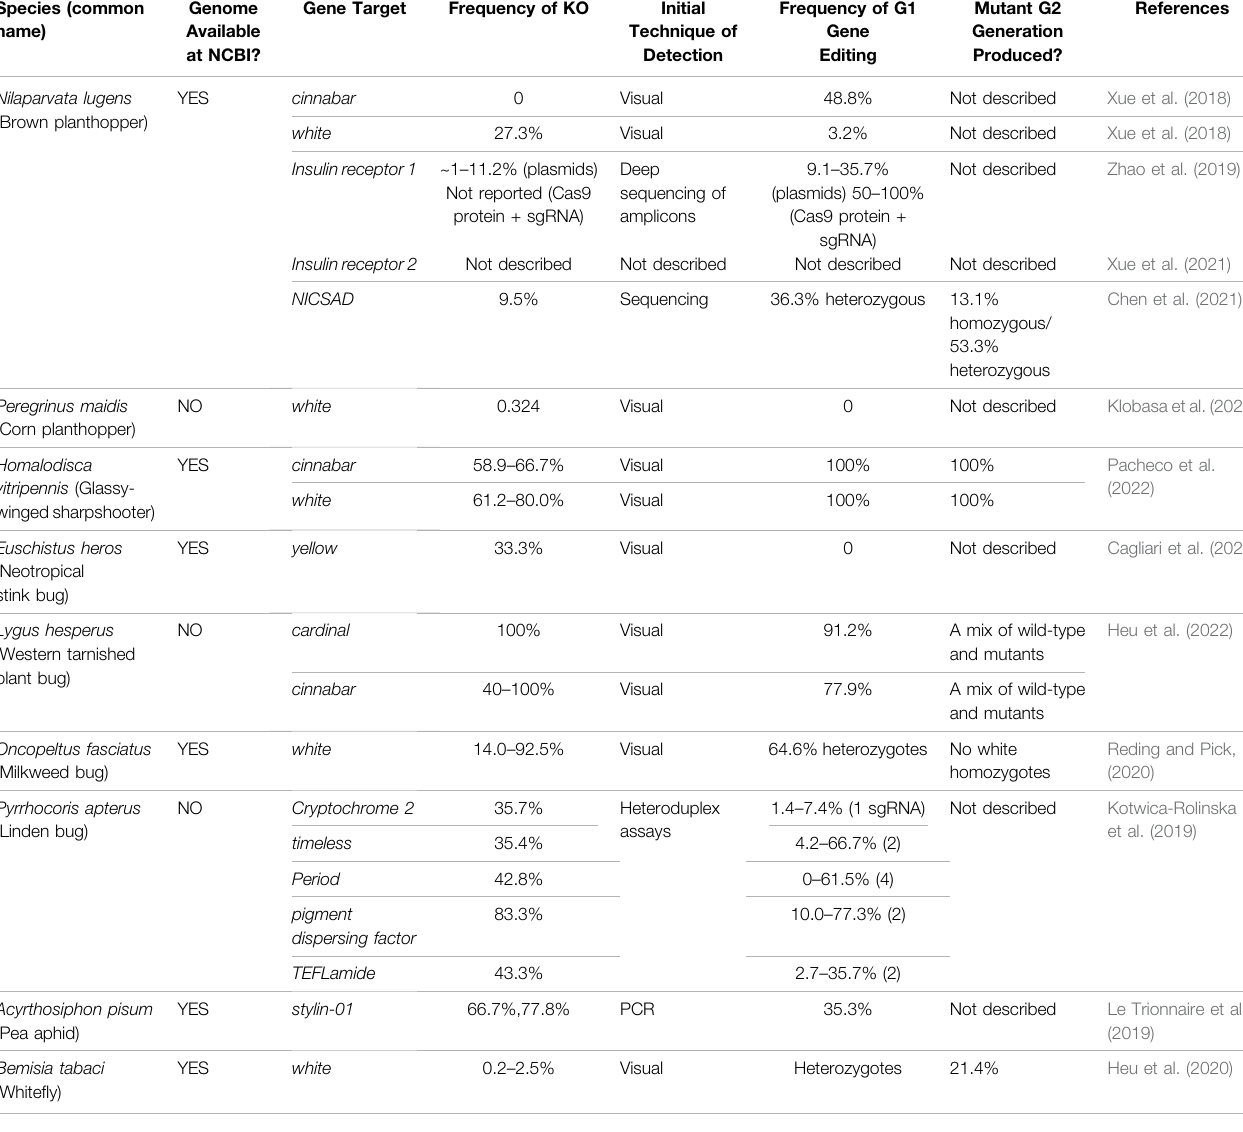
TABLE 2 | The gene targets and ef fi ciencies of CRISPR/Cas9-mediated mutagenesis in Hemiptera.